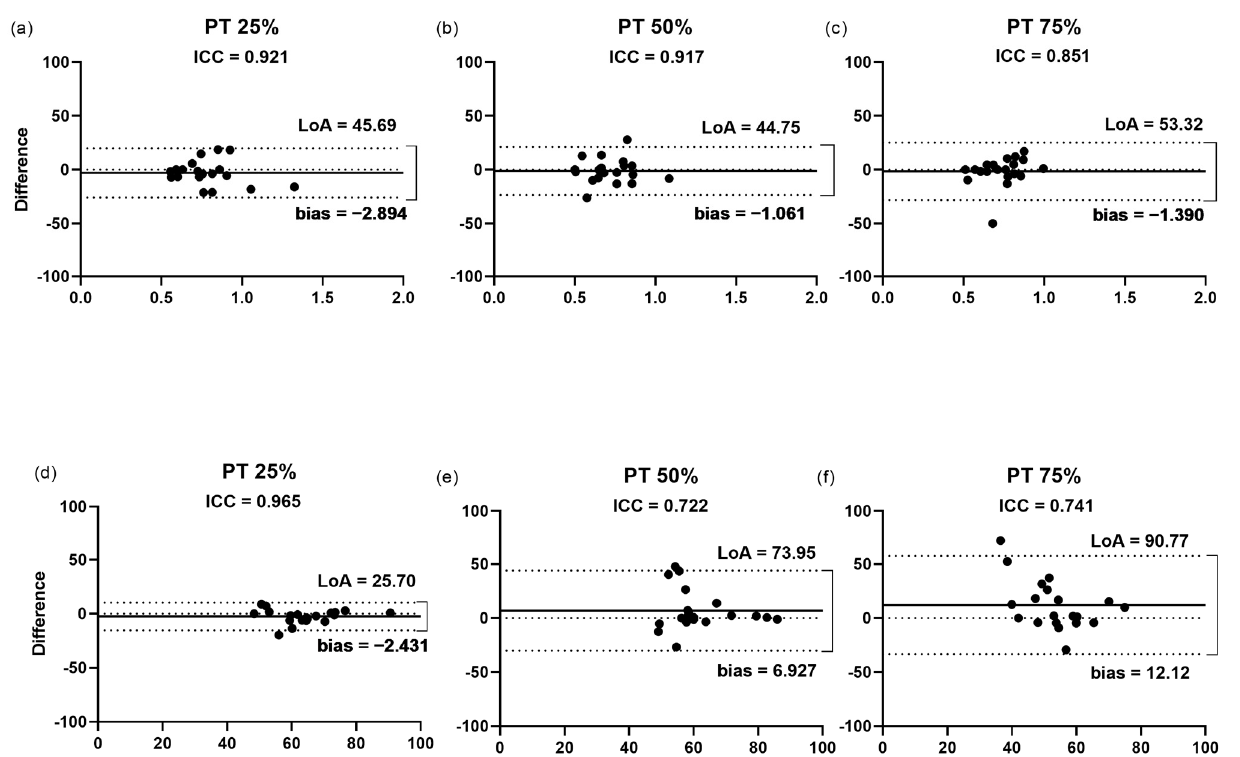
Figure 7. Bland–Altman plots displaying the differences (expressed as %) plotted against the average CSA and echogenicity recorded by the two raters for each PT position. Inter-rater reliability of CSA ( a – c ) and echogenicity ( d – f ) measurement for ( a , d ) 25%; ( b , e ) 50%; and ( c , f ) 75%. The lines show the zero, bias, and random error lines. Dashed lines represent the 95% limits of agreement (LoA). CSA, cross-sectional area; LoA, limits of agreement; PT, patellar tendon.